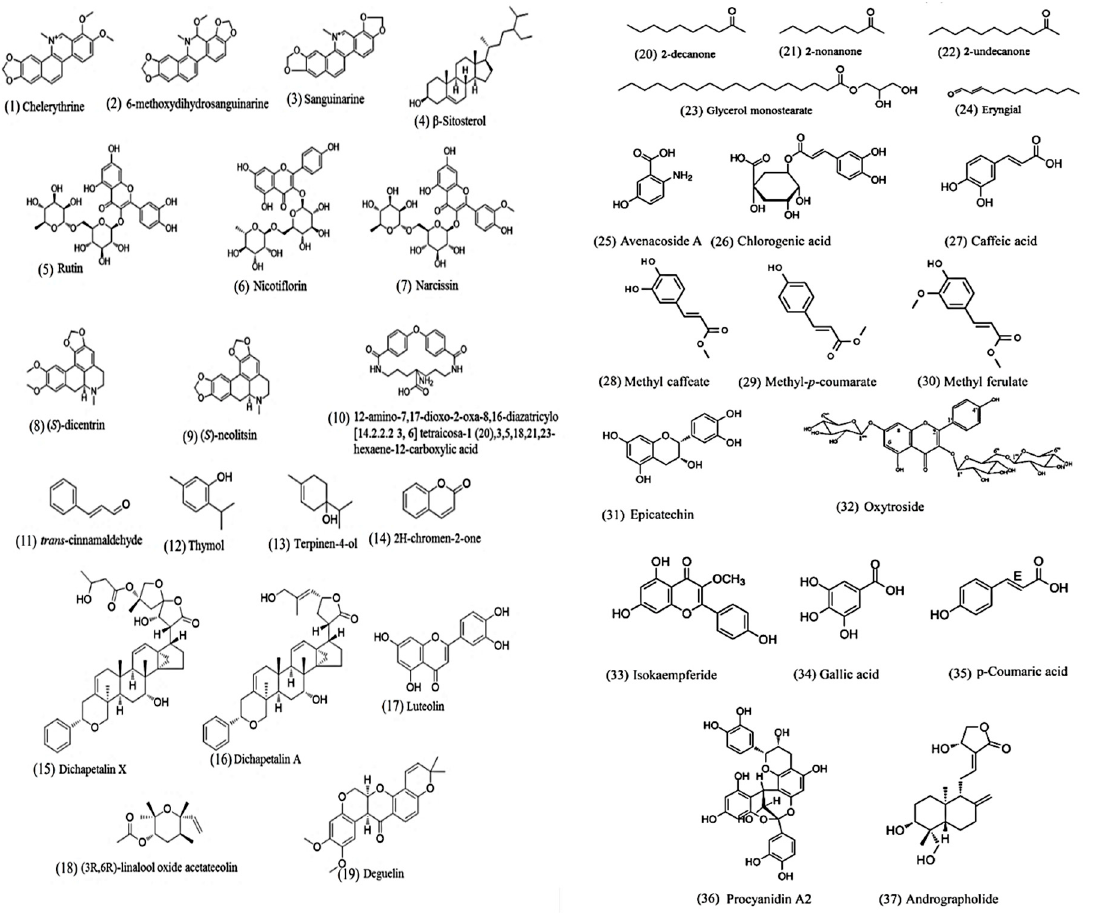
F igure 1. Chemical structures of natural products active against intestinal parasitic nematodes.